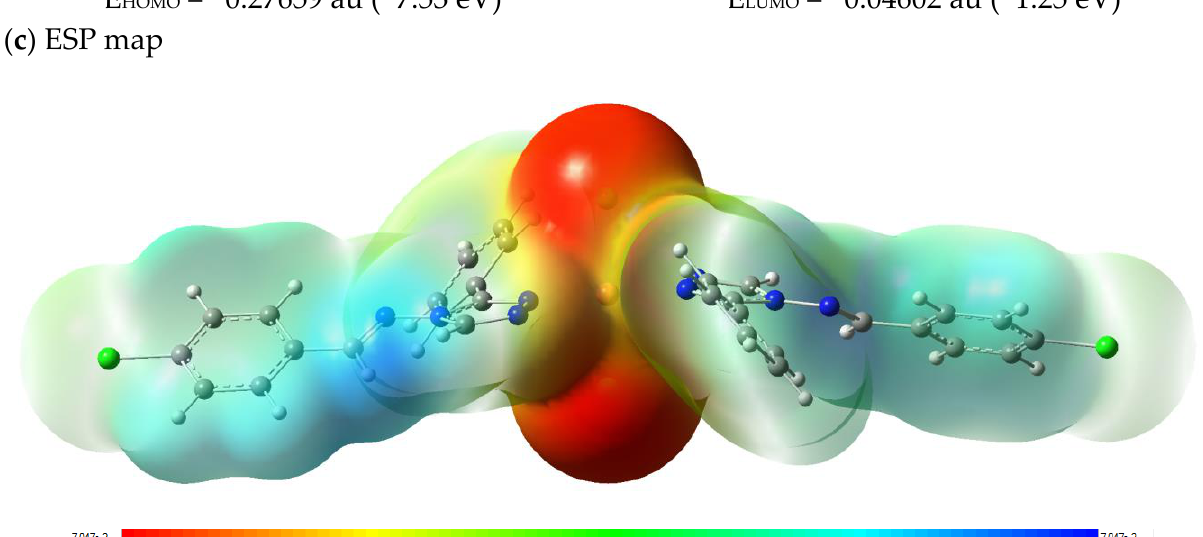
Table S4). It also required a higher activation barrier (30.8 Kcal mol – 1 ) for this conversion. Computed bond dissociation enthalpies (BDEs) for thione – thiol tautomers also provided